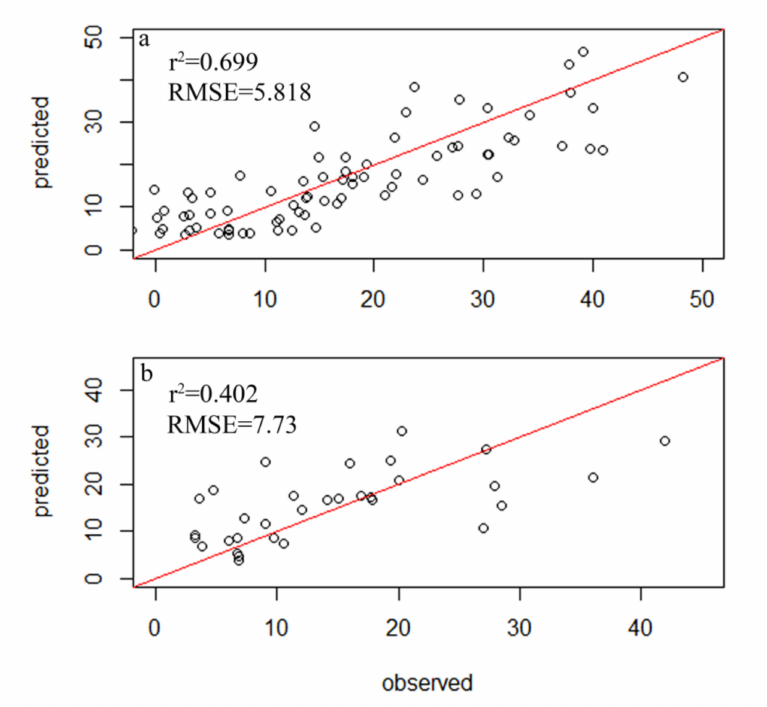
Figure 3. Relationship between the observed and diatom-inferred COD obtained via weighted averaging without tolerance down-weighting regression: ( a ) test group; ( b ) control